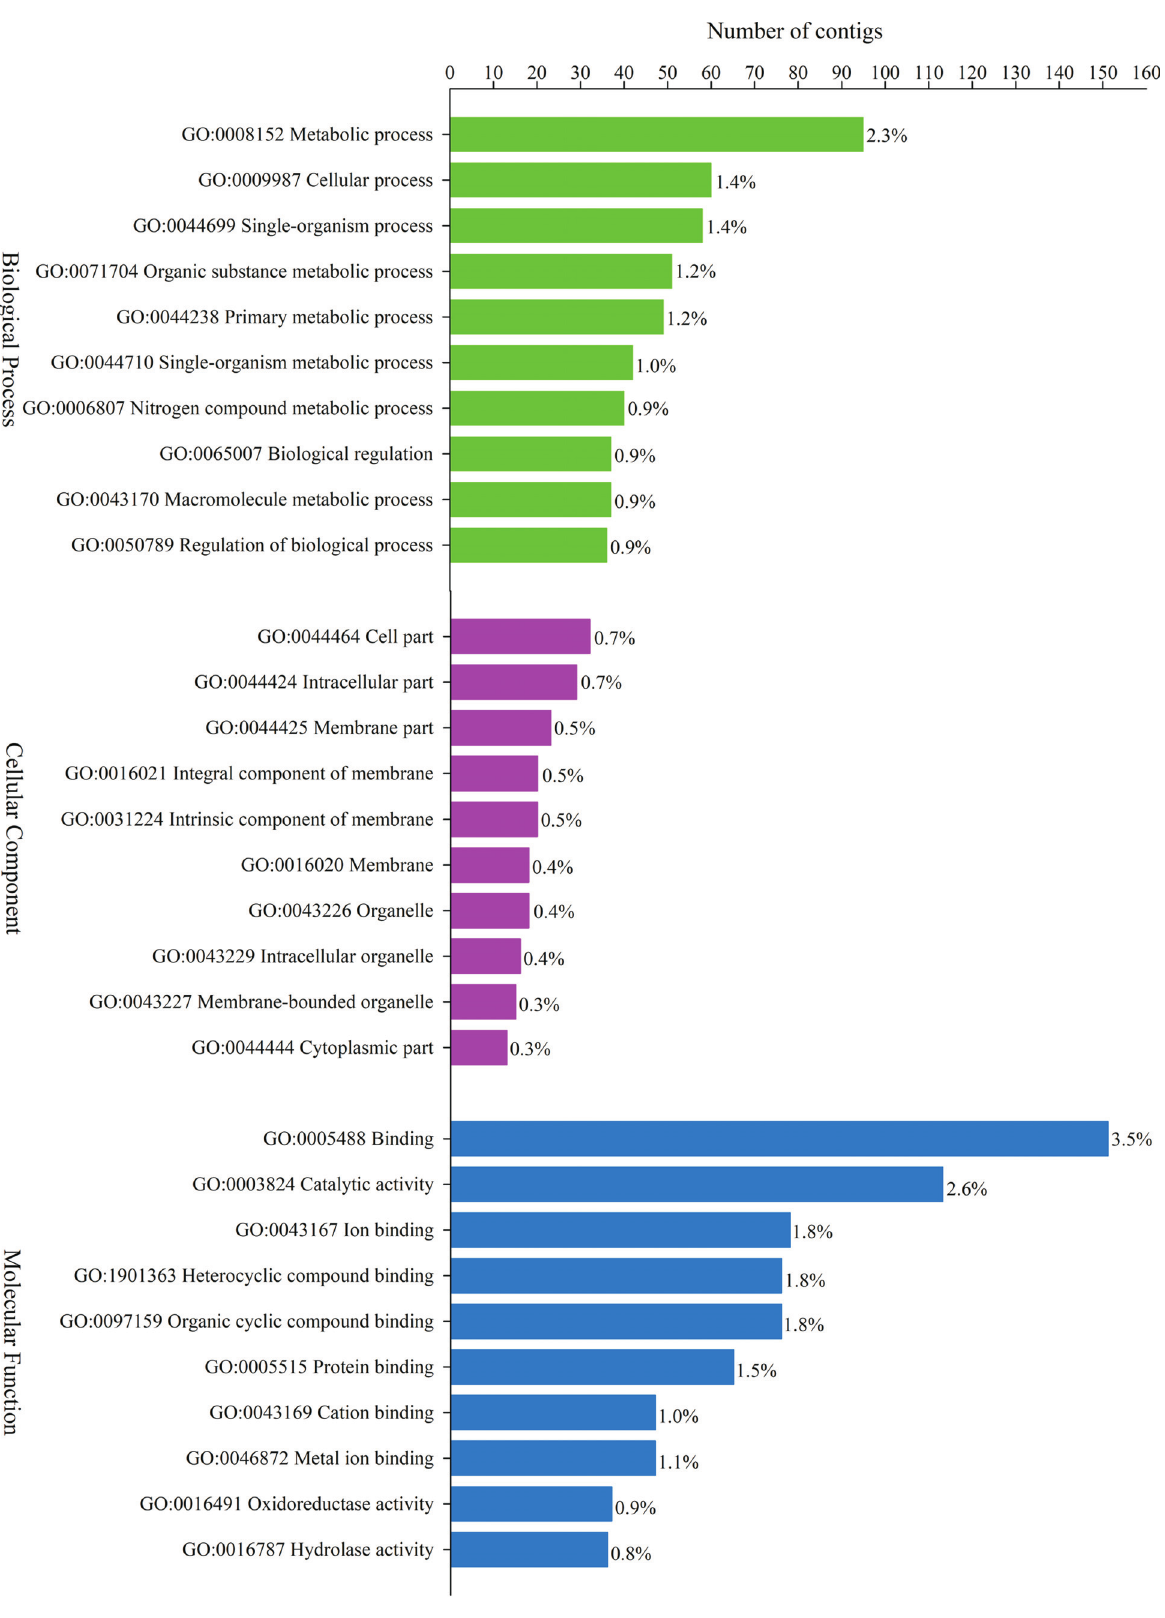
Figure 3 - The top 30 terms classification of the contigs significantly upregulated in Brumado population and separated into three functional Gene Ontol- ogy (GO) categories: Biological Process (green bars), Cell Component (purple bars) and Molecular Function (blue bars). The percentages indicate the representation of genes that belong to each